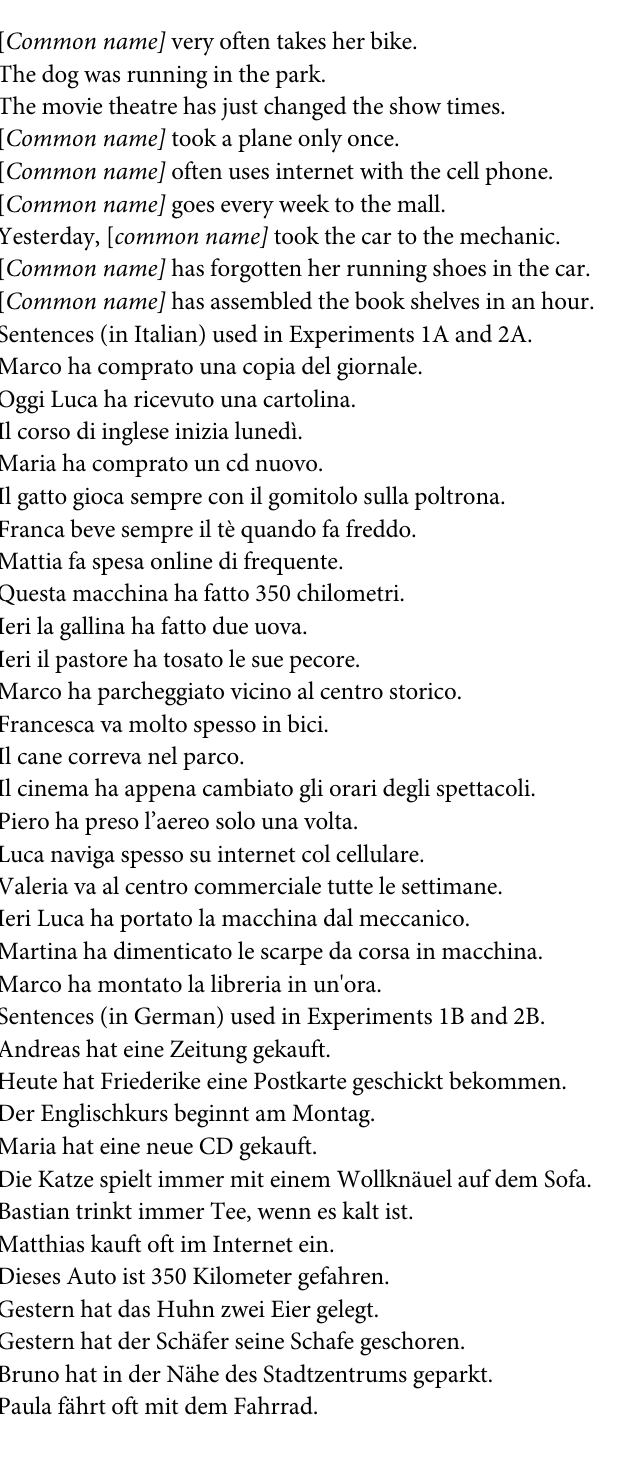
S1 Table. Experiment 1A & 1B: Statistics for each Speaker. Legend:. .1; (cid:1) < .05; (cid:1)(cid:1) < .01; (cid:1)(cid:1)(cid:1) < .001; ns: non significant; cluster: 1 = heterosexual; 2 =